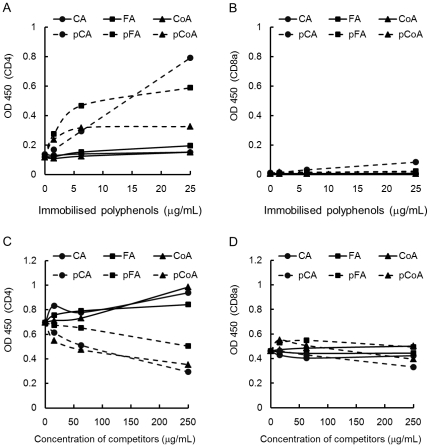
Binding capacity of the polymerised polyphenols to CD4 molecules.Each well of the ELISA plate was coated with various polyphenols (0–25 µg/mL) and blocked. Polyphenols bound to the wells were incubated with His-tagged (A) CD4 or (B) CD8a protein, washed, and probed with peroxidase-conjugated anti-6-His antibody. The binding affinity of the CD4 or CD8a molecule for the polyphenols was assessed using a colorimetric assay with the peroxidase substrate TMB and phosphate. The absorbance was measured at 450 nm. Reverse ELISA experiment was performed by coating the ELISA plate with (C) His-tagged CD4 or (D) CD8a protein and blocking. The plate was incubated with various polyphenols diluted to achieve concentrations of 0–250 µg/mL, washed, and further treated with anti-CD4 or CD8a mAb. The plate was probed with peroxidase-conjugated anti-Rat IgG antibody; the binding of anti-CD4 or CD8a mAb to solid-phase CD4 or CD8a protein was monitored using TMB, and the absorbance was measured as mentioned above.